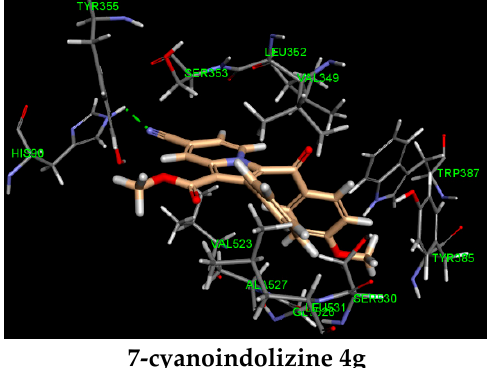
Figure 4. Predicted docking pose of indolizines 4b – g (salmon-filled spheres) in the COX-2 domain (PDB 4COX). Hydrogen bonding interaction is represented as a green dotted line.